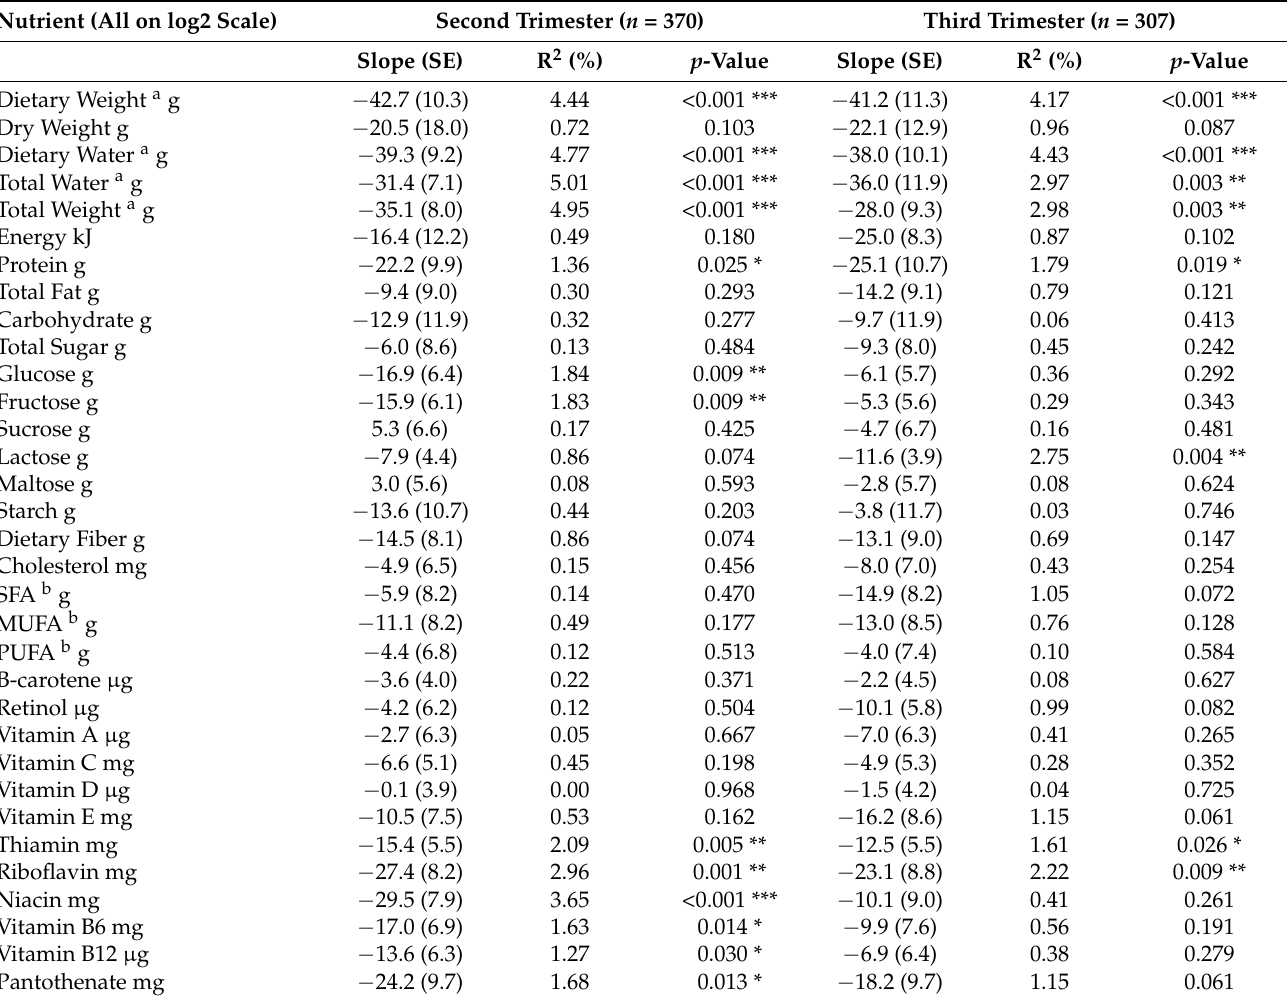
Table 2. Relationship between log2 (nutrient intakes) and minutes of TIB in the second and third trimester; each nutrient is considered on its